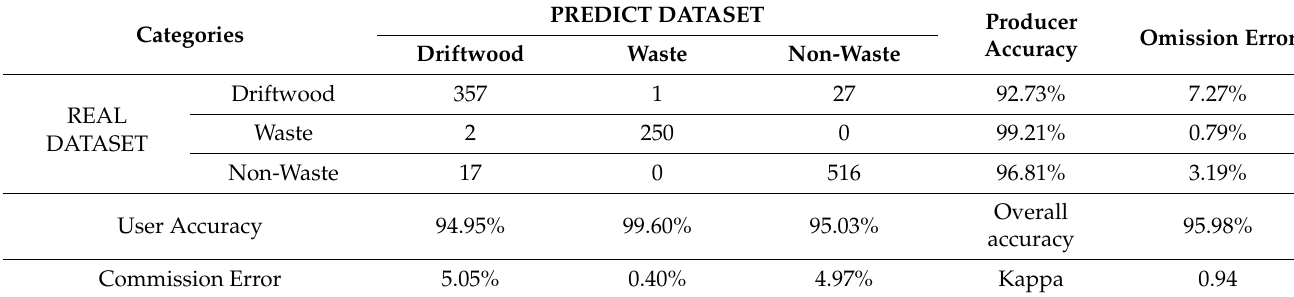
Table 5. Confusion matrix for AE +